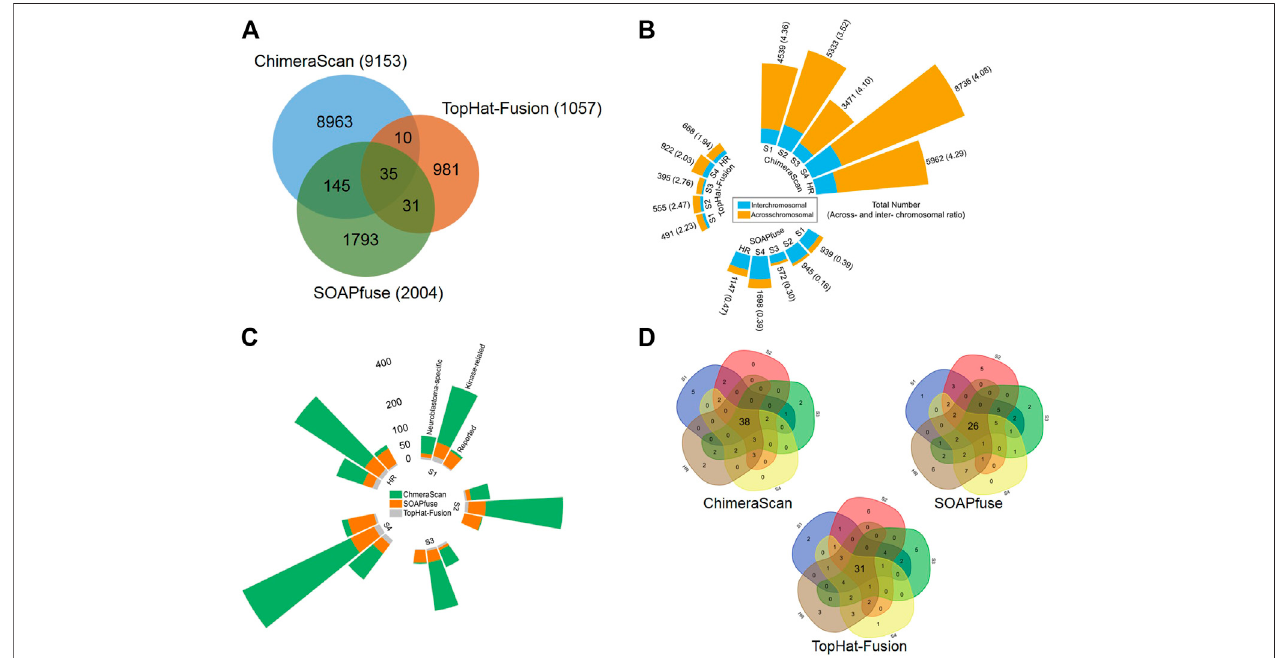
FIGURE2| Comparativeanalysisandannotationofidenti fi edgenefusionsbythreealgorithms,includingChimeraScan,SOAPfuse,andTopHat-Fusion: (A) aVenn diagram of detected fusions among three algorithms; (B) Distribution of detected gene fusions in different INSS clinical stages and high-risk group. The yellow and blue colorrepresentstheinter-andacross-chromosomalgenefusion,respectively; (C) Thedetectedfusionsineachclinicalstagewerefurtherannotatedbyreportedcancer- related gene fusions, kinase-related fusions, and neuroblastoma key gene-related gene fusions; (D) The high-frequency gene fusions for each algorithm were extracted across the different clinical